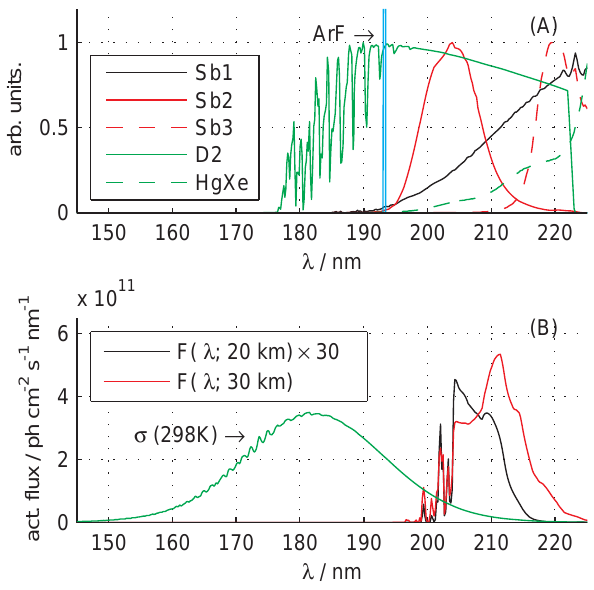
Fig. 1. Panel (A) : The spectra of the various lamps used in the broadband photolysis studies of Kaiser et al. (2002, 2003) and R¨ockmann et al. (2001a,b). “Sb1”, “Sb2” and “Sb3” refer to Sb lamp without filter, with 200nm filter and 220nm filter, respec- tively. The position of the ArF excimer laser line used in the latter study is also shown. Panel (B) : The N 2 O cross section compared to the actinic flux F(λ) at different